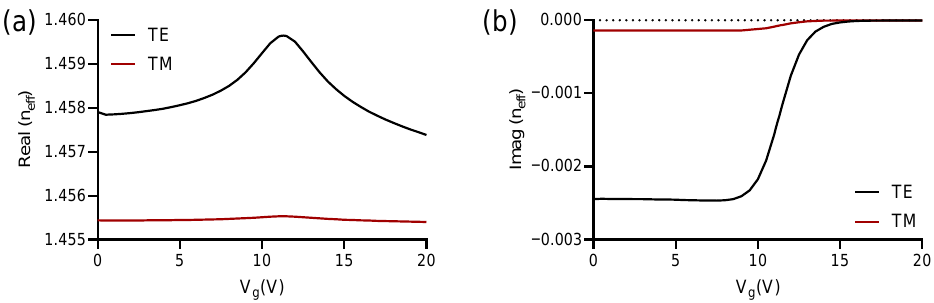
Figure 4. Variation of the ( a ) real and ( b ) imaginary parts of the effective refractive index for TE and TM modes as a function of the gate voltage ( V g ) variation.